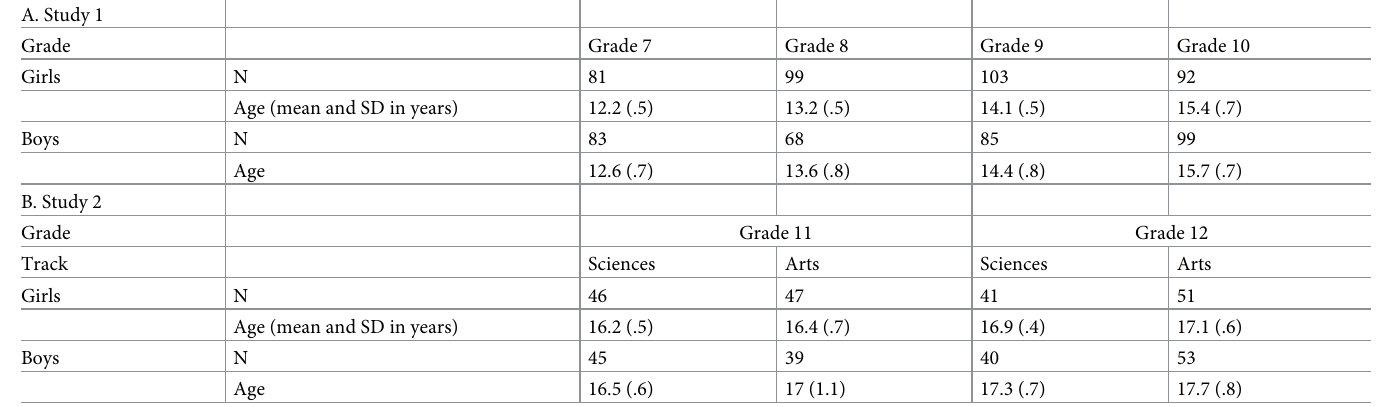
Table 1. Characteristics of participants in Study 1 and